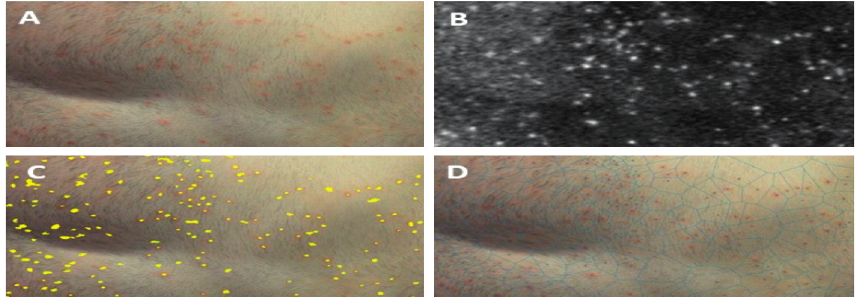
Figure 1: (a) Skin area affected with psoriasis. (b) Enhanced lesion representation by a ∗ color channel of lab space. (c) Segmented lesions (yellow spots) superimposed on the initial image to visualize the result of morphological processing. (d) Lesions’ centroids generating Voronoi